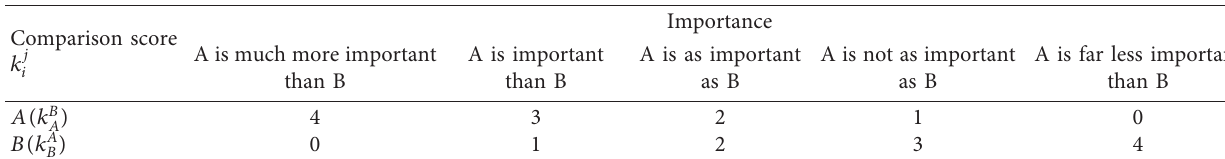
Figure 9: Functional decomposition diagram of power source Table 1: 0–4 scoring standard table.